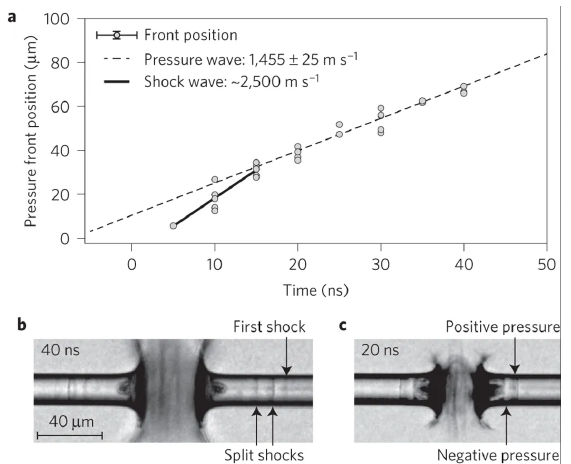
Figure 4. Graph ( a ) plots the position of the first pressure front seen in ( b ) as a function of time. Images ( b , c ) show still frames of an otherwise stable liquid jet, exploding from the X-ray pulse. Shock waves split into multiple pressure fronts and travel transversely along the liquid jet. Figure originally published in Nat. Phys.